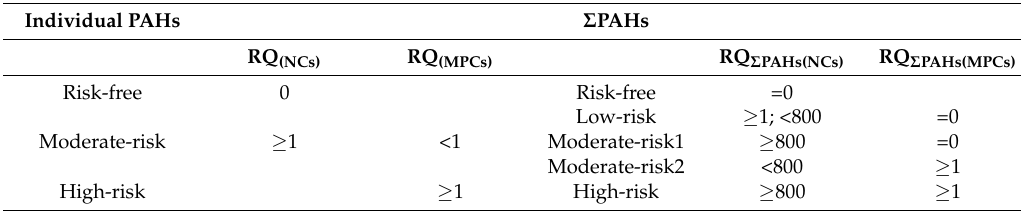
Table 1. Ecological risk classification of individual and total PAHs.